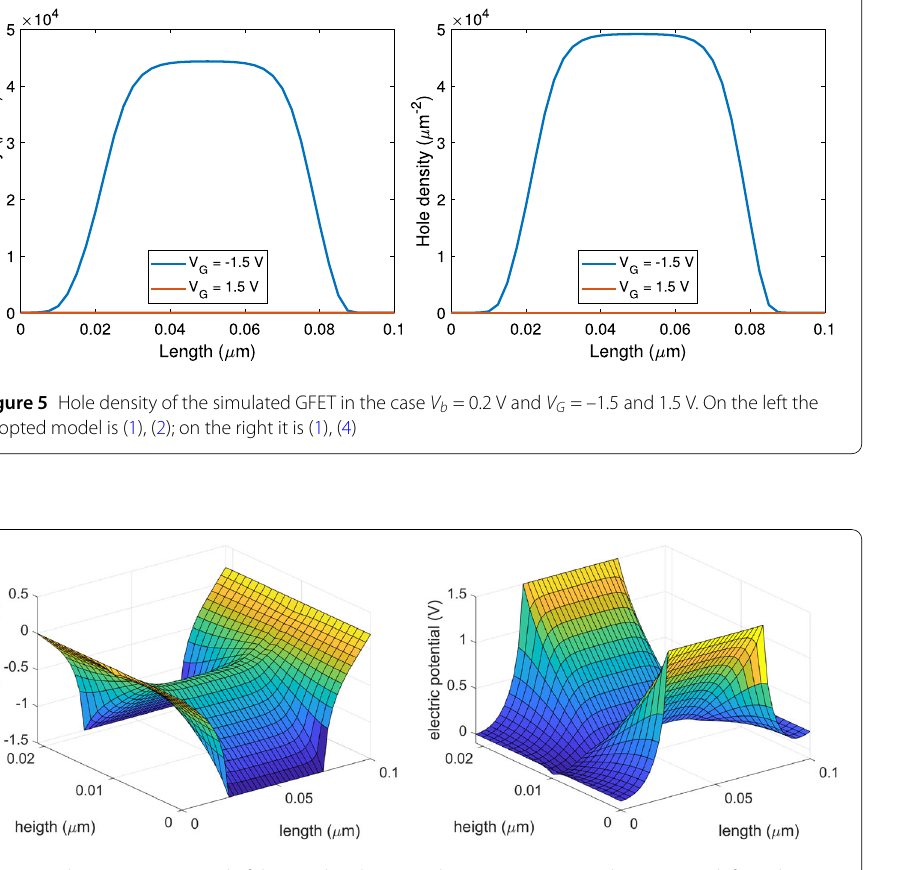
Figure 6 Electrostatic potential of the simulated GFET in the case V b = 0.2 V and V G = –1.5 V (left) and V G = 1.5 V